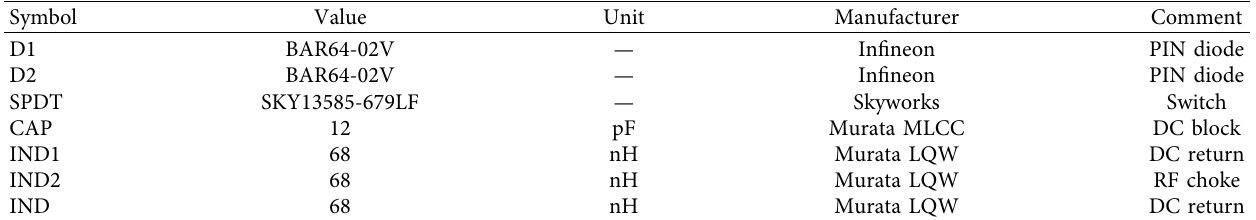
Table 1: Electronic components used in the proposed reconfigurable